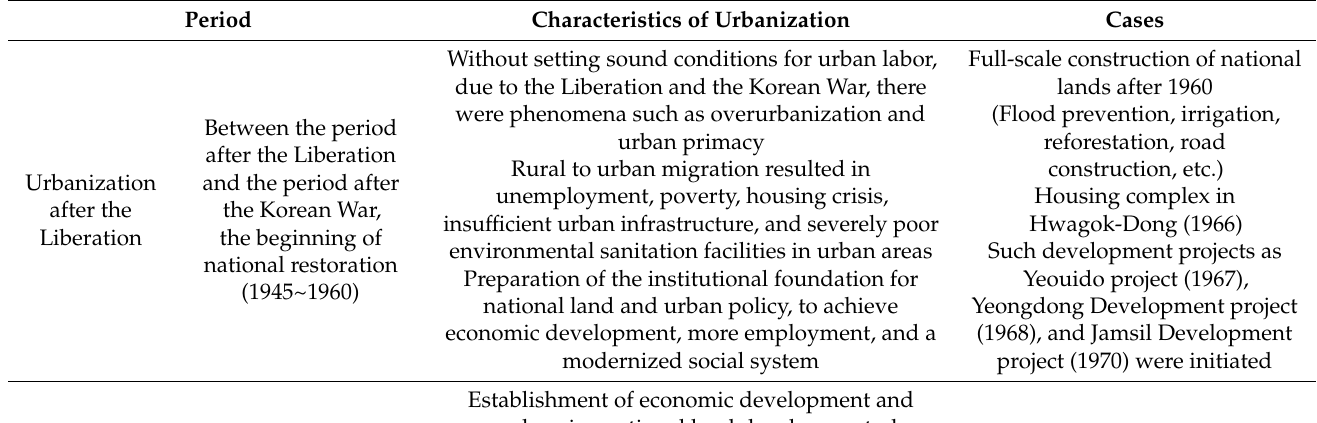
Table 4. Characteristics of urbanization and relevant cases in South Korea by